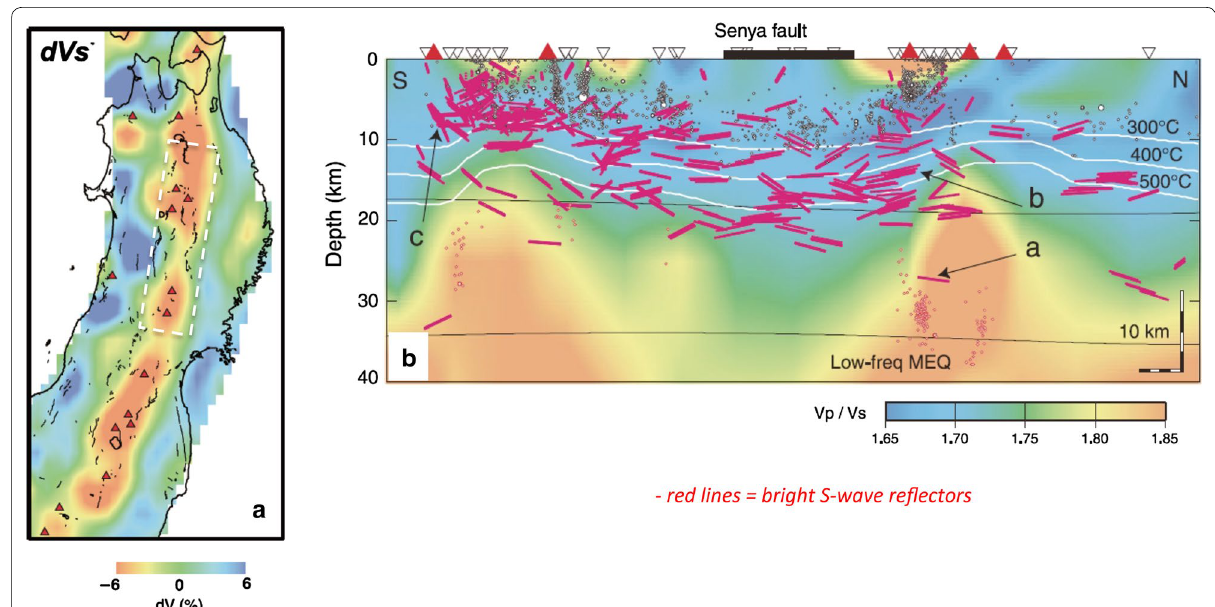
Fig. 9 a Map of northern Honshu with volcanic front in Ou Backbone Range (flanked by inward-dipping reverse fault systems) delineated by lowered dVs ; b N–S longitudinal section along the Ou Backbone Range (white rectangle) showing bright S-wave reflectors (red lines) in relation to the depth of the seismogenic zone, estimated isotherms, and variations in Vp/Vs (from Hasegawa 2017)